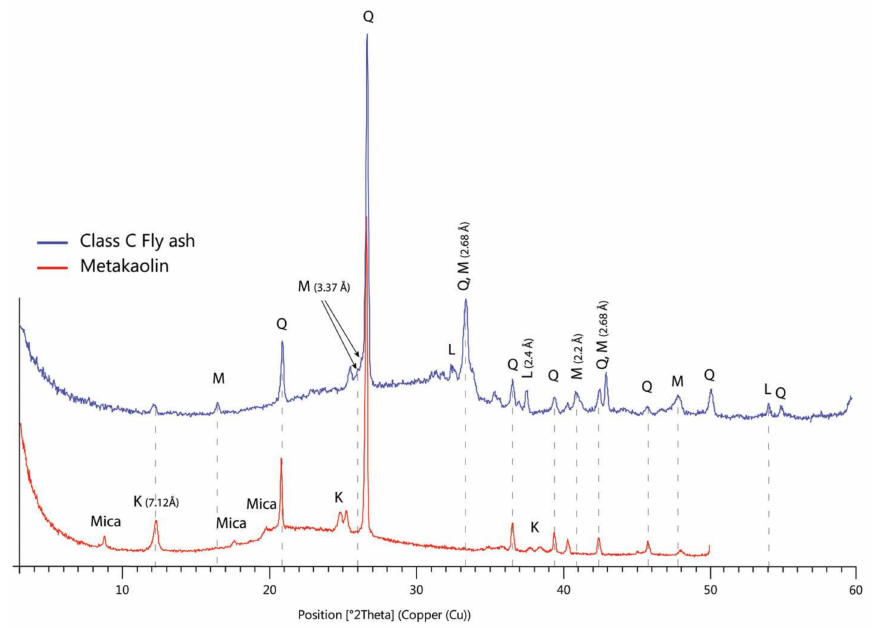
Figure 4. The X-ray diffraction (XRD) patterns of aluminosilicate source, class C fly ash (FAC), and metakaolin (MK). Mineral abbreviations: M: mullite; K: kaolinite; Q: quartz; L: lime